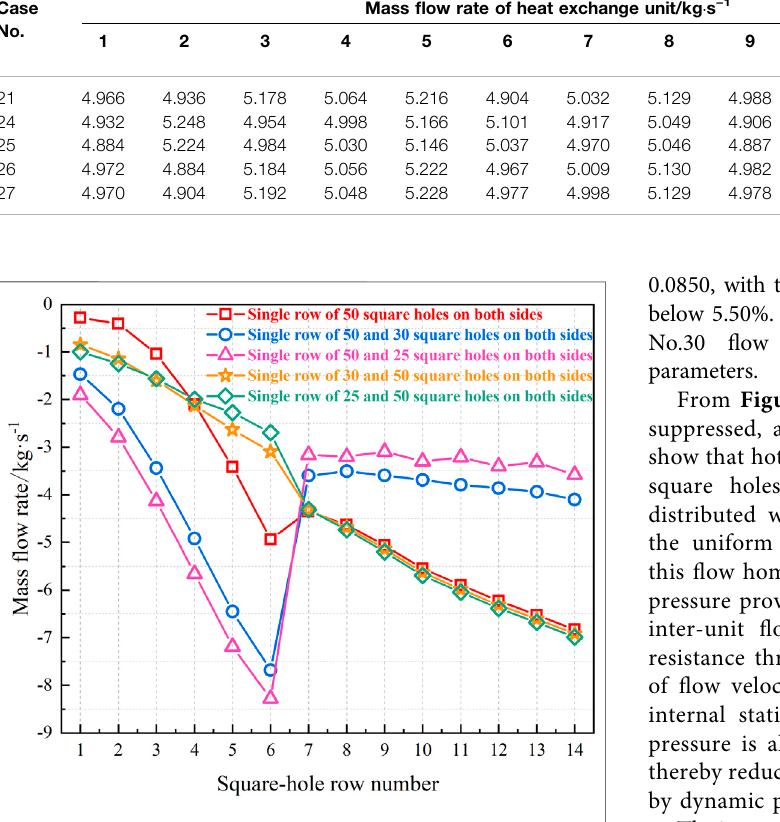
FIGURE 13 | Flow distribution characteristics of fl ow homogenizers with different square hole numbers in a single row.